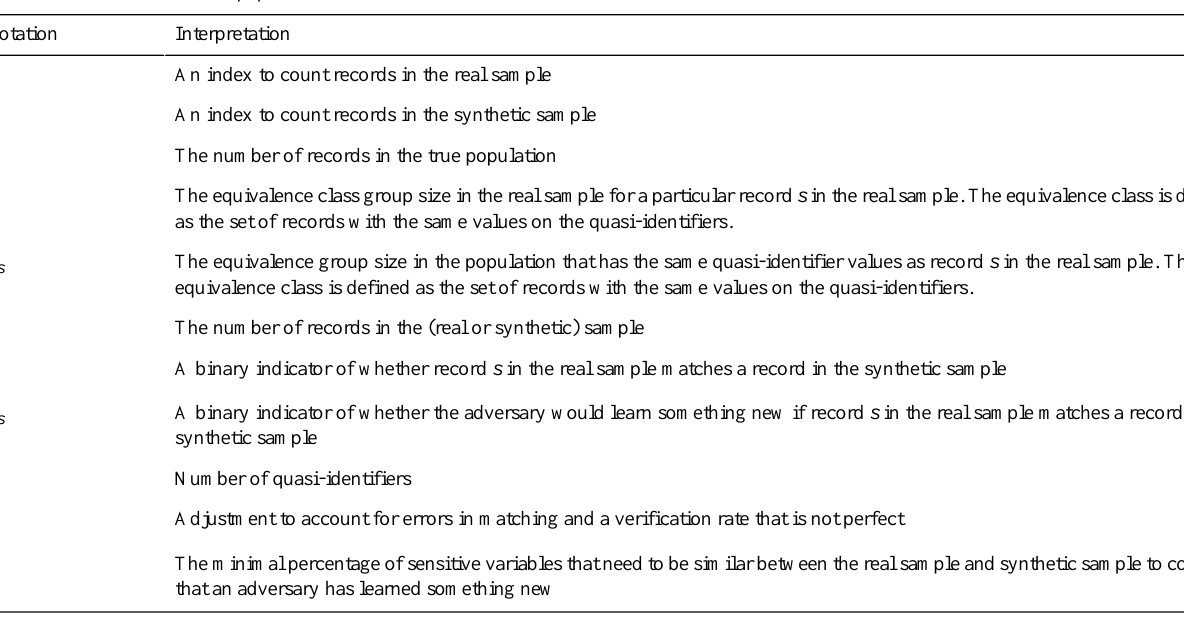
Table 4. Notation used in this